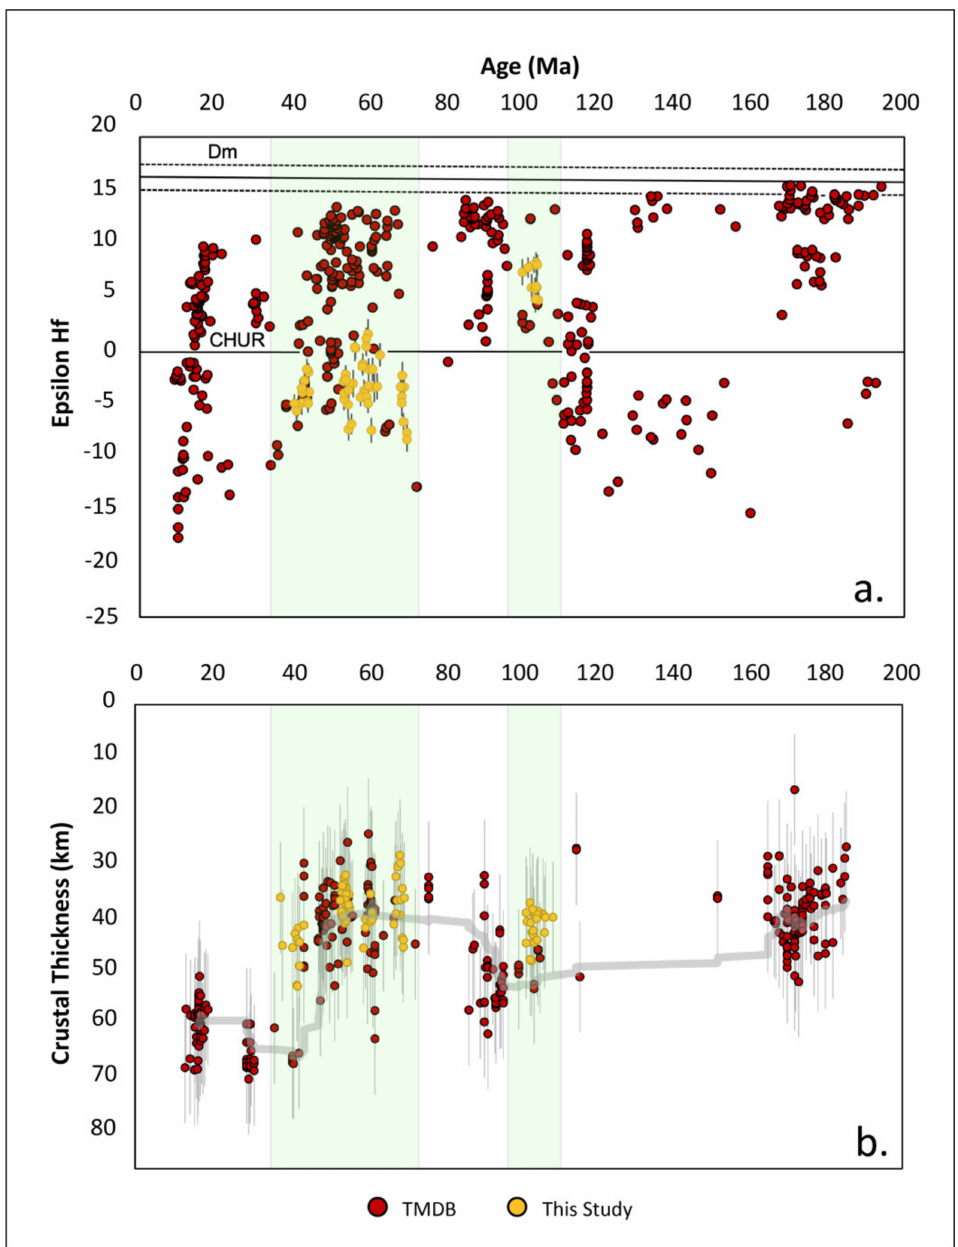
Figure 10. ( a ) Epsilon Hf vs. U-Pb geochronology plots for igneous zircons from this study in the context of regional data downloaded from the Tibetan Magmatism Database (TMDB) (Chapman and Kapp, 2017). CHUR and Dm explanations can be referenced in Figure 5. Lu-Hf filtering criteria for TMDB samples can be referenced in the methods section of this paper; ( b ) T/REE geochemistry crustal thickness estimates vs. U-Pb geochronology crystallization age plots from this study in the context of crustal thickness estimates for regional data downloaded from the Tibetan Magmatism Database (TMDB) (Chapman and Kapp, 2017). TMDB crustal thicknesses were calculated using the equations from Sundell et al. (2021), with data filtered to exclude ultramafic/mantle derived melts, high silica granites, and rocks formed by partial melting of pre-existing meta-sedimentary rocks. Error bars represent ± 10.8 km residuals (Sundell et al., 2021). Gray trendline represents a moving average with a sampling period of 30